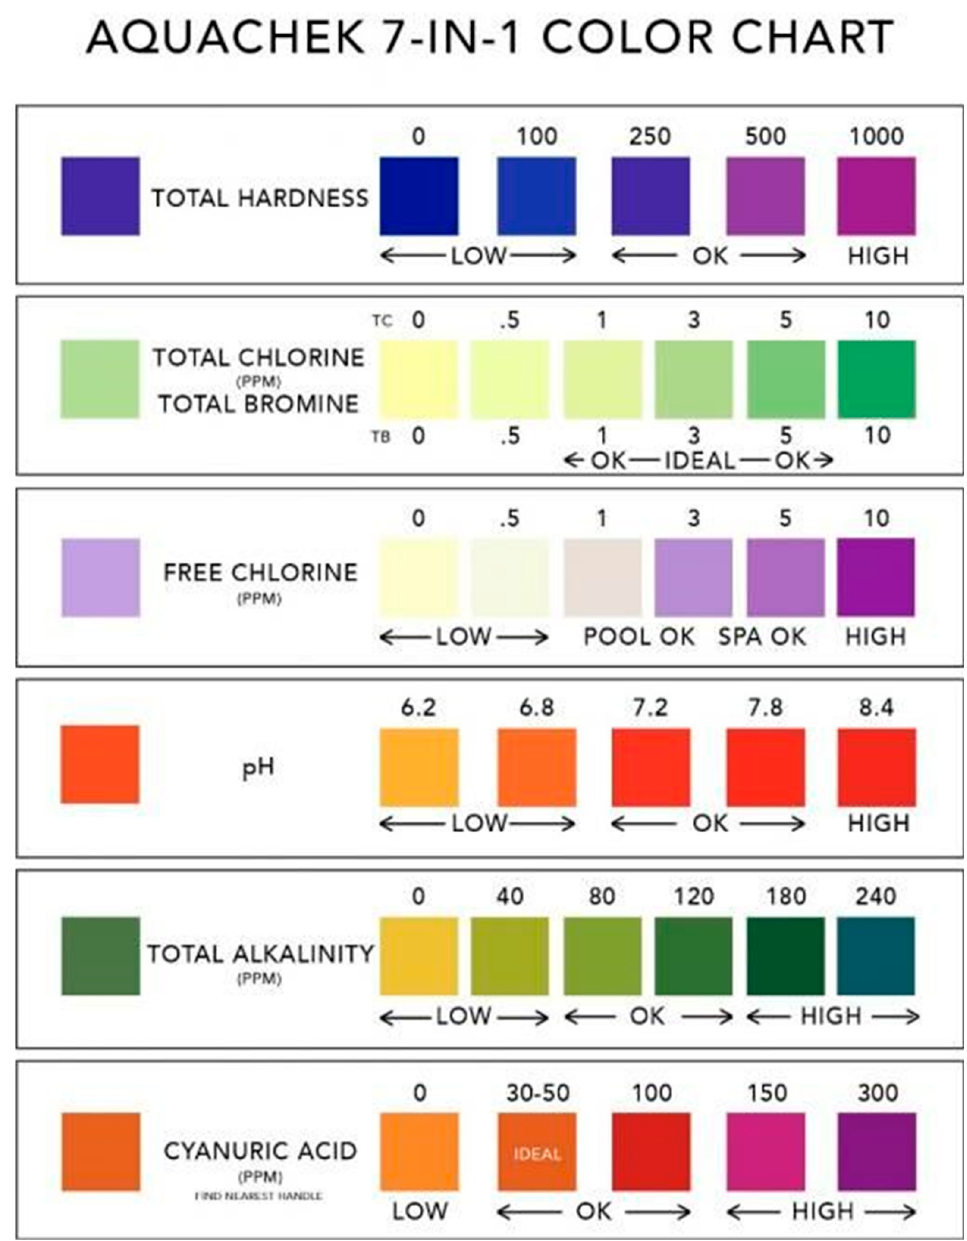
Table 3 shows the color quanti fi cation summary of the AquaChek Color Chart, which indicates the chemical levels in hot tub water.